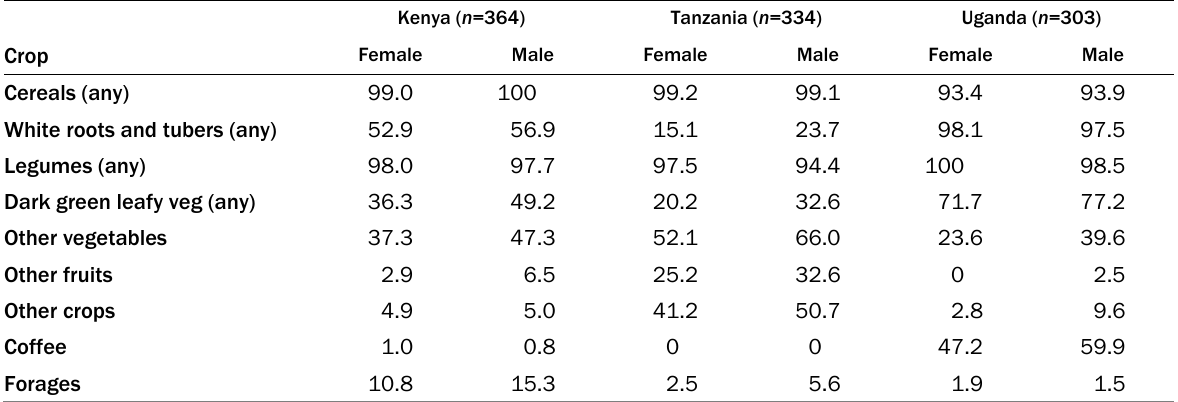
Table 5. Crop Categories Grown, Percent of Households by Country and Gender of the Household Head Kenya ( n= 364) Crop Female Male Cereals (any) 99.0 White roots and tubers (any) Legumes